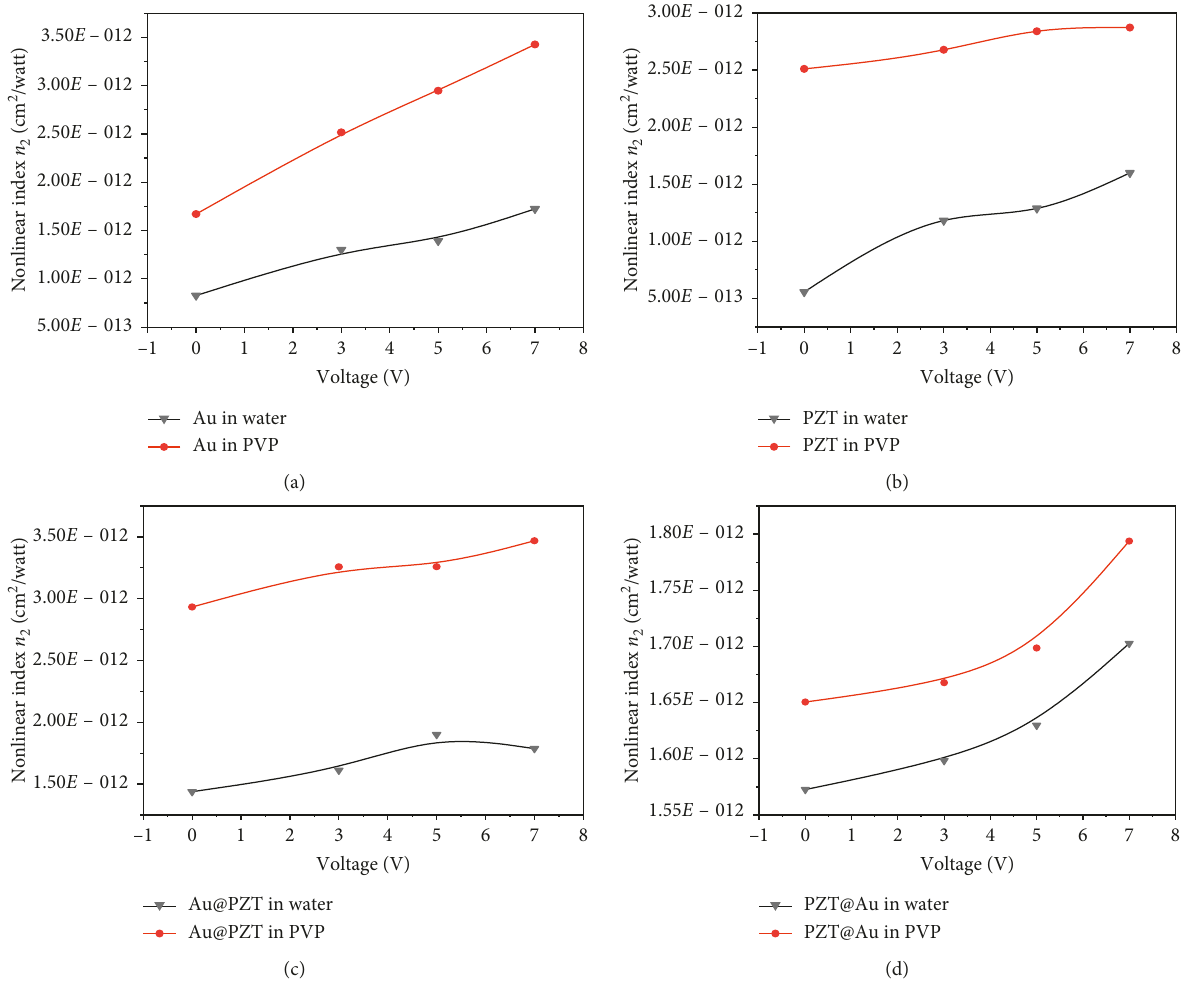
Figure 10: Change in the nonlinear refractive index by changing solution and voltages for all